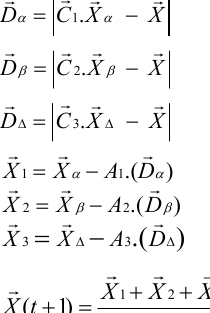
Initialization of the population a, A and C